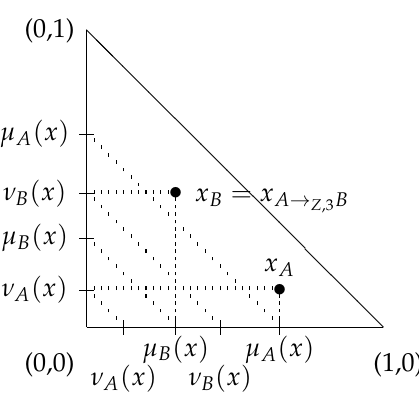
Fig. 3: Geometrical interpretations of elements x A , x B and x A